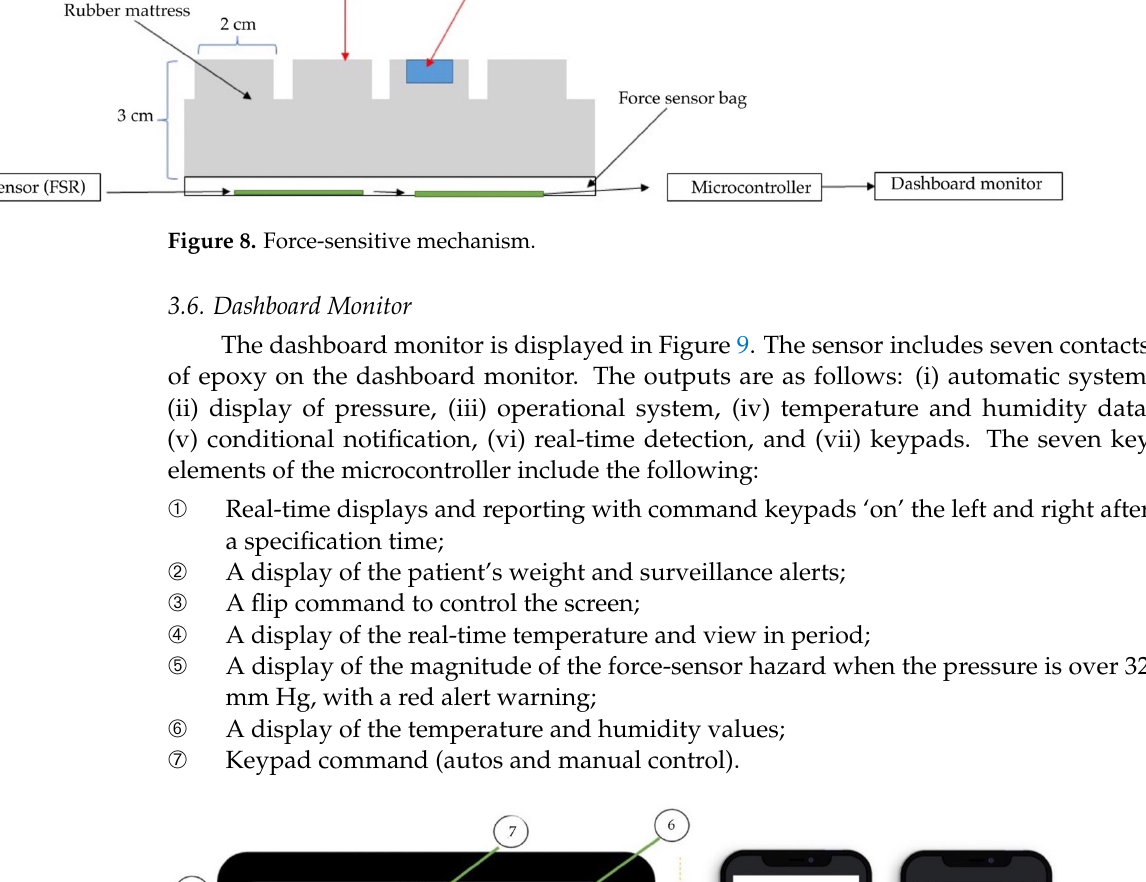
Figure 8. Force-sensitive mechanism.